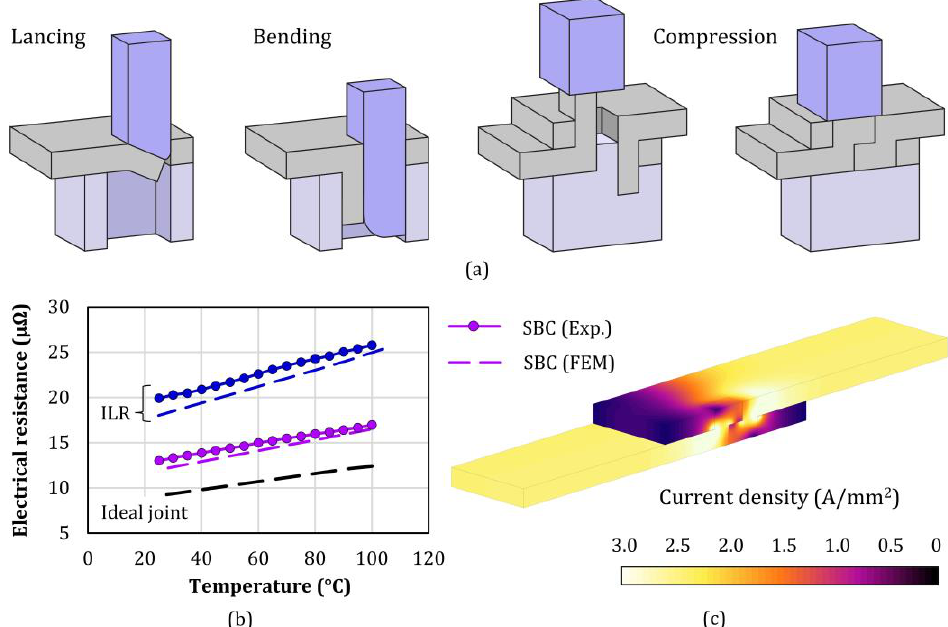
Figure 13. Sheet-bulk compression (SBC) of aluminum busbar joints: ( a ) schematic view of the fab- rication process, ( b ) experimental and finite element predicted evolutions of the electrical resistance with temperature, and ( c ) finite element predicted distributions of electric current density (A/mm 2 ) when the temperature at the center is equal to 85 °C.